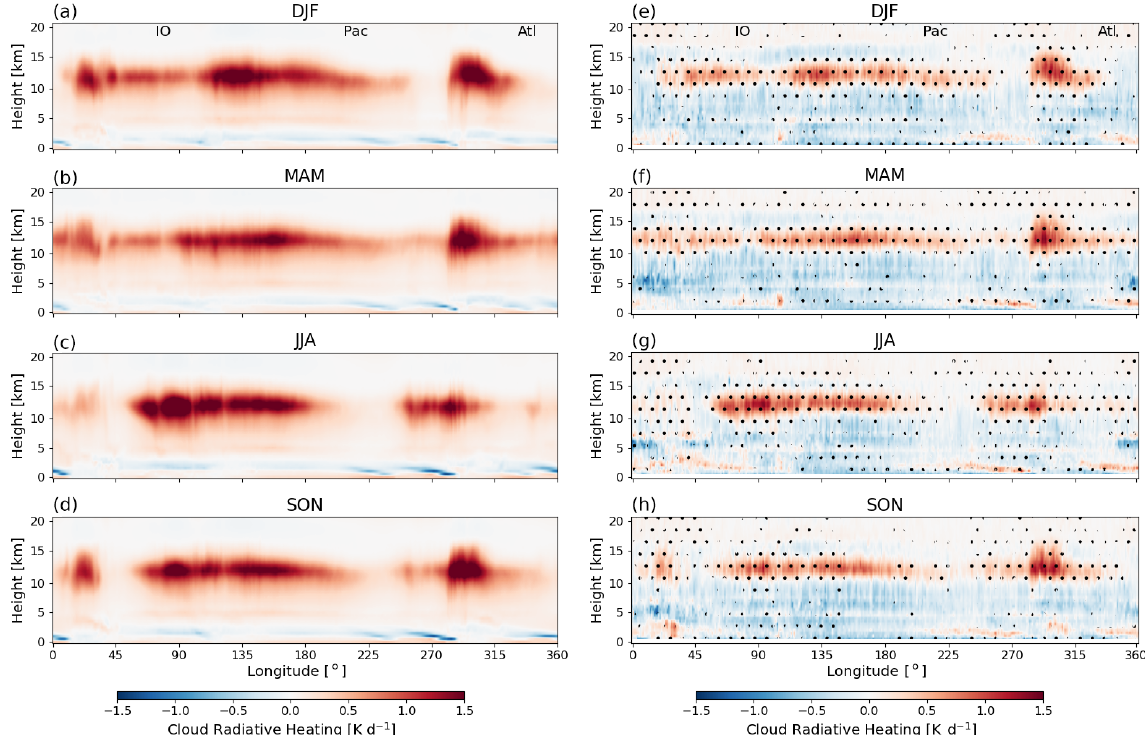
Figure 2. As in Fig. 1 but showing (a–d) the vertical structure of cloud radiative heating from the high-resolution EC-Earth (EC-Earth3P-HR) and (e–h) the difference in cloud radiative heating, between CloudSat/CALIPSO observations (Fig. 1) and EC-Earth3P-HR (EC-Earth3P-HR minus CloudSat/CALIPSO). Statistically significant differences, at the 95% confidence using a Student t test based on monthly mean values, are marked with black dots (e–h)